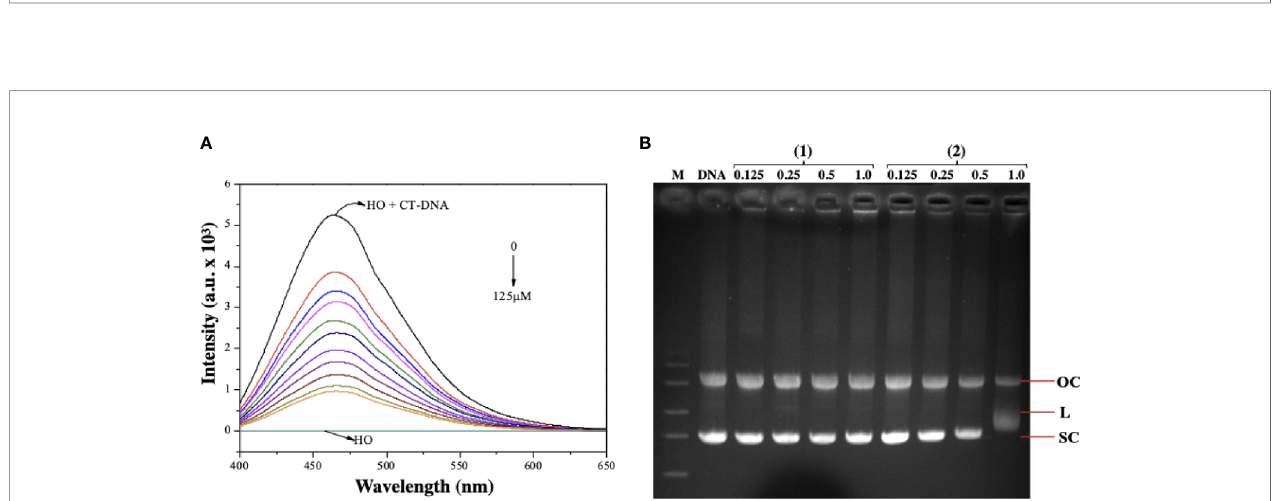
FIGURE 7 | Interaction of ruthenium-containing ruthenium complexes with DNA molecule. (A) Emission spectra of Hoechst (HO) (2.7 µM, l ex = 343 nm), CT-DNA (125 µM) in presence of the complex (2) in different concentrations (0 - 125 µM). (B) Agarose gel electrophoresis image of pBR322 plasmid DNA incubated with complexes ( 1 ) and ( 2 ). The pBR322 presents three forms, OC (open circular), L (linear) and SC (supercoiled). Lane 1 (M): molecular weight marker; lane 2 (DNA): pure pBR322 with DMSO; lanes 3 – 6 [complex ( 1 )] and lanes 7-10 [complex ( 2 )].